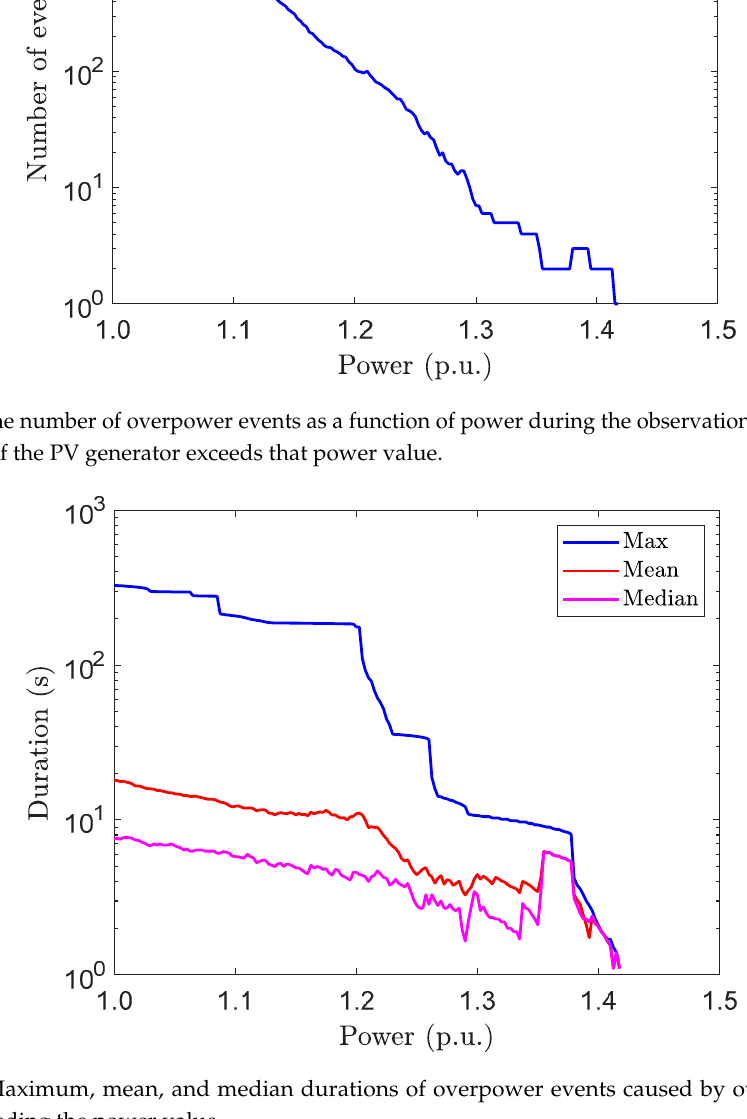
Figure 7. The number of overpower events as a function of power during the observation period when the power of the PV generator exceeds that power value.